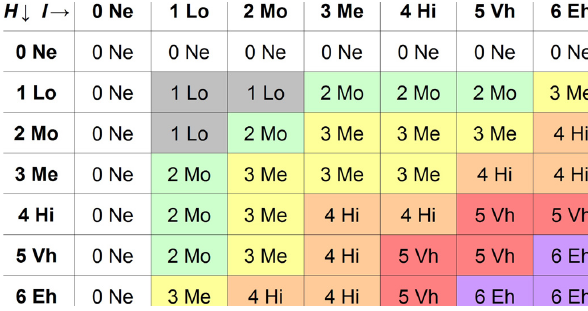
Fig. 3. Lake outburst hazard H : combination of lake area as sur- rogate for the possible lake outburst magnitude M and suscepti- bility S . Ne=negligible, Lo=low, Mo=moderate, Me=medium, Hi=high, Vh=very high, Eh=extremely high.